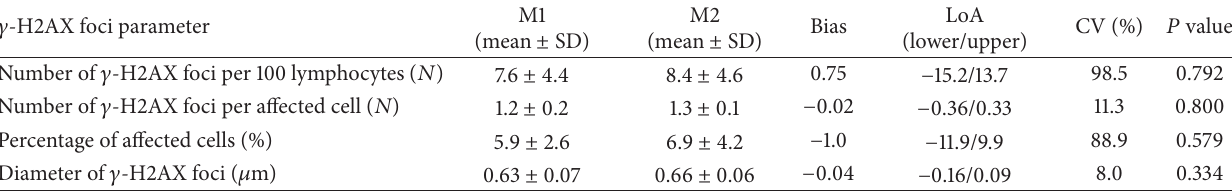
M2 LoA Bias CV (%) 𝑃 value (mean ± SD) (mean ± SD) (lower/upper)